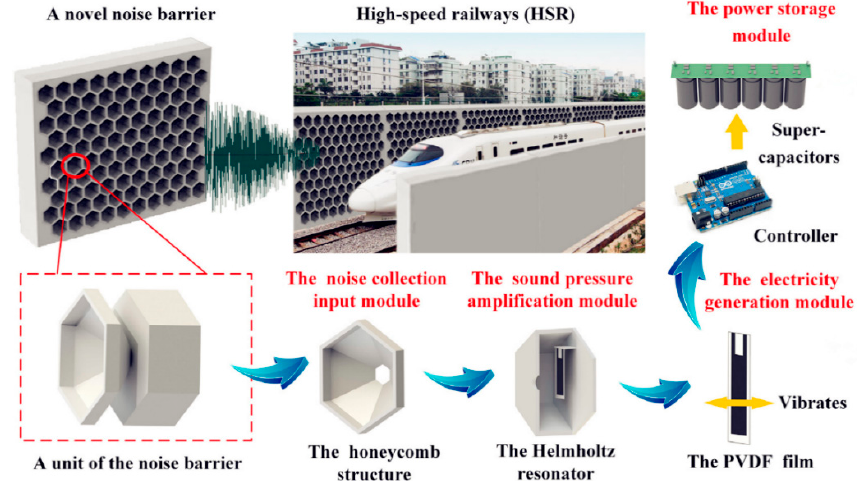
Figure 14. Components of the AEH unit and the array form to create a noise barrier. Reproduced with permission from [48]; published by ELSEVIER, 2018.